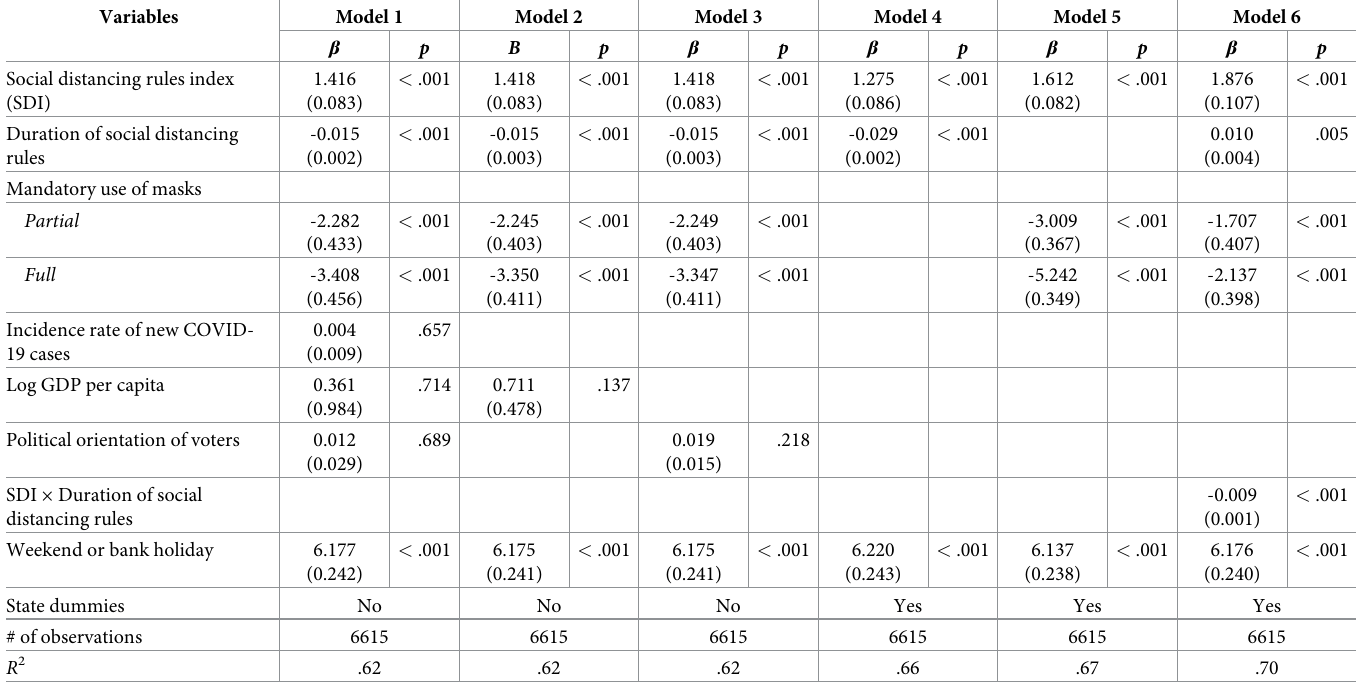
Table 3. Determinants of social distancing in Brazil. Regression analyses considering six models (11 th March– 10 th November 2020).